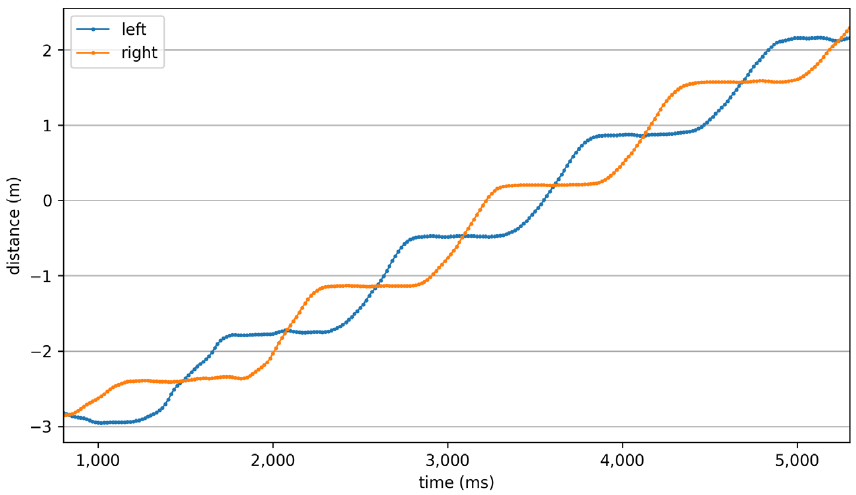
Figure 7. Distance from the origin of left (blue) and right (orange) foot, respectively, for one of the subjects involved in the